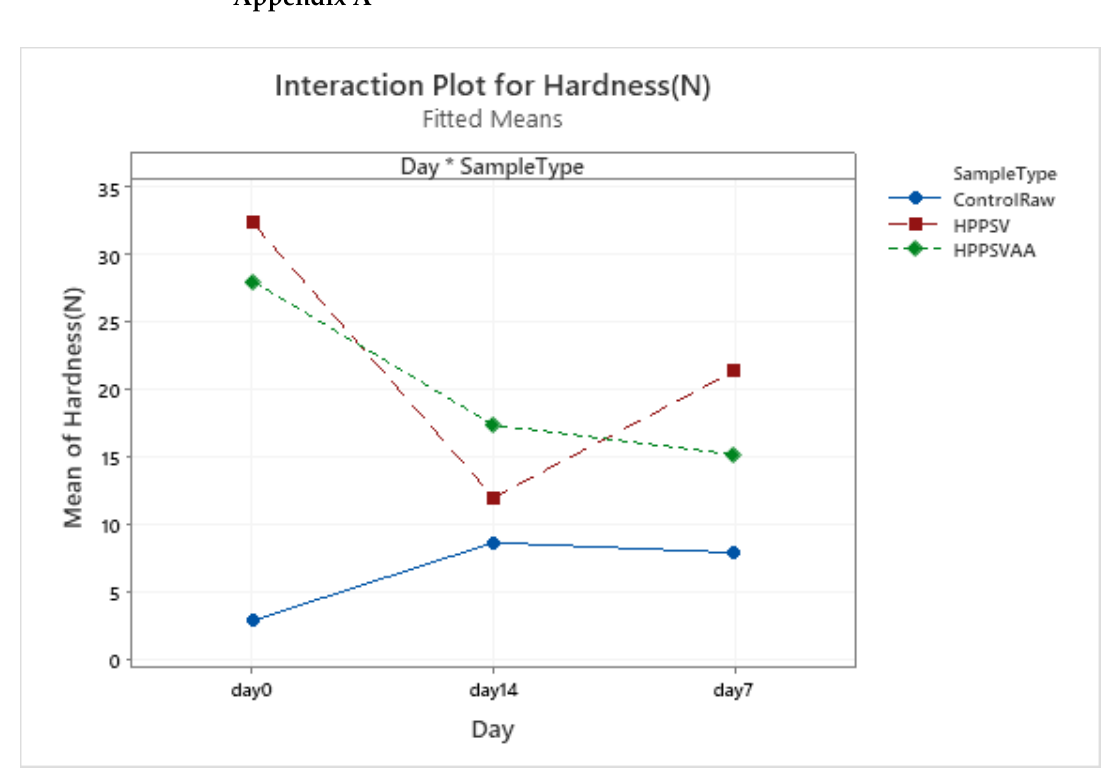
Figure A1 . Effect of treatments and storage time on the hardness of veal patty (HPPSV: HPP- SVCOOK).